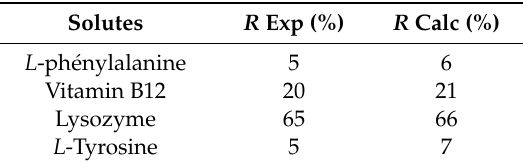
Figure 2. SEM photographs of ( a , b ) cross section at different enlargements and ( c ) top view of the active layer. Table 4. Experimental and calculated (pore size distribution) rejection rate of solutes (membrane with initial properties).